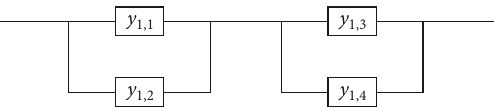
Figure 6: Block diagram of hardware component of module 𝑀 𝑁,1 . The left block describes the GNSS receiver and the right is for the GNSS